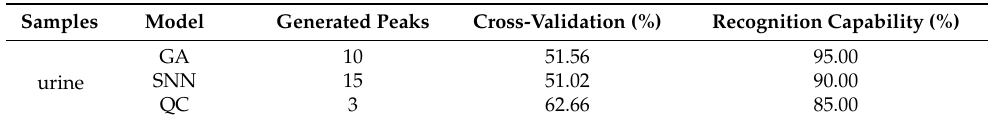
Table 1. Results of a cross-validation test and recognition capability test of the GA, SNN, and QC models to distinguish the two groups (control and CIN3) in the urine samples. Samples